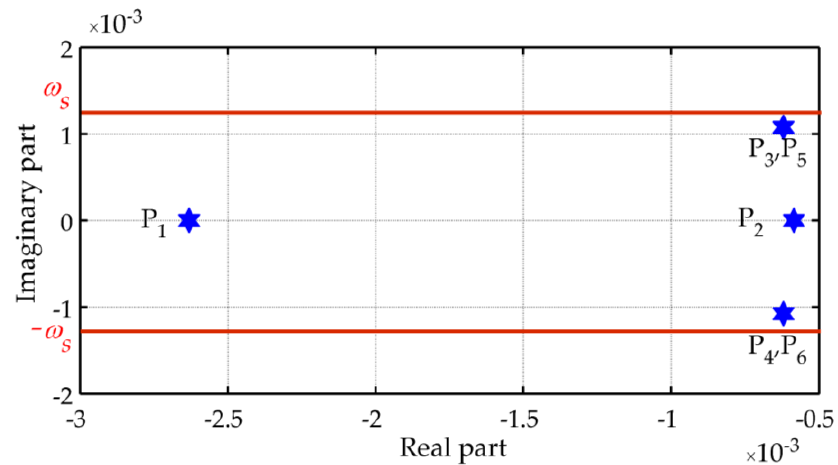
Figure 2 . Pole plot of I ( s ) ( μ = 0.5, ζ = 1.296) .